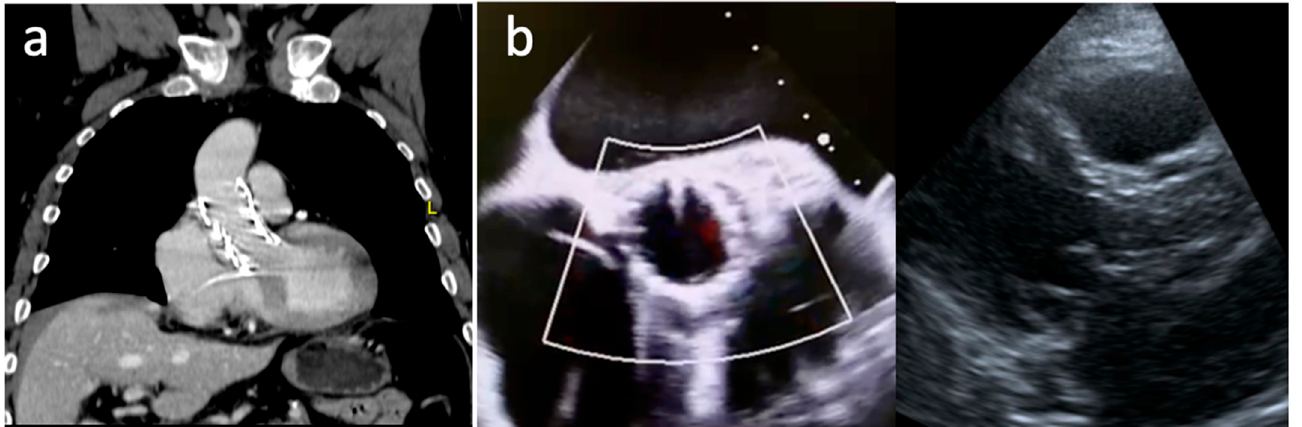
Figure 5. The control computed tomography angiography ( a ) and transthoracic echocardiogram ( b ) showing a well-positioned and normo-functioning THV with no residual AR and a mean gradient of 10 mmHg.